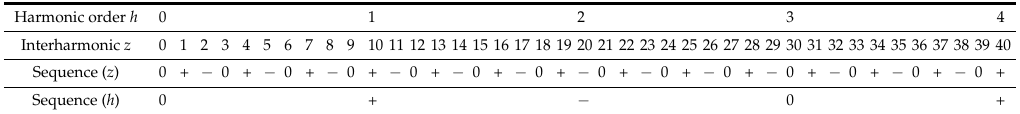
Table 3. Sequences for the harmonic and interharmonic orders under the consistency conditions (symbols: + for positive sequence, − for negative sequence, and 0 for zero